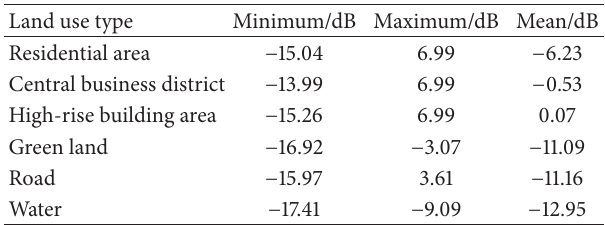
Table 3: Backscattering coefficients of various land use types extracted from ALOS PALSAR